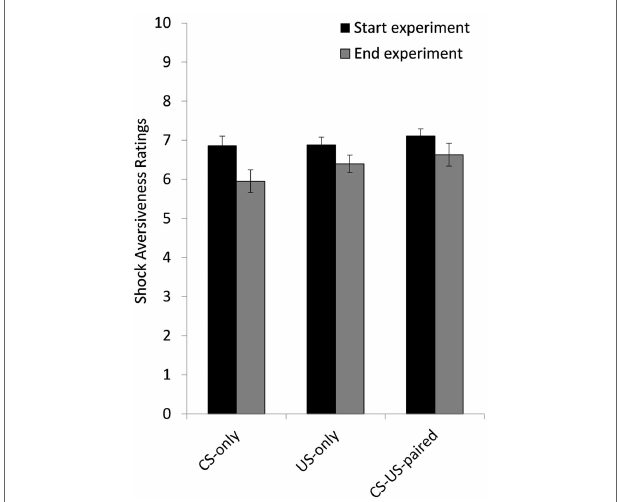
FIGURE 4 | Mean ratings of shock aversiveness at the start and at the end of the experiment for group CS-only, US-only, and CS-US-paired. Error bars represent